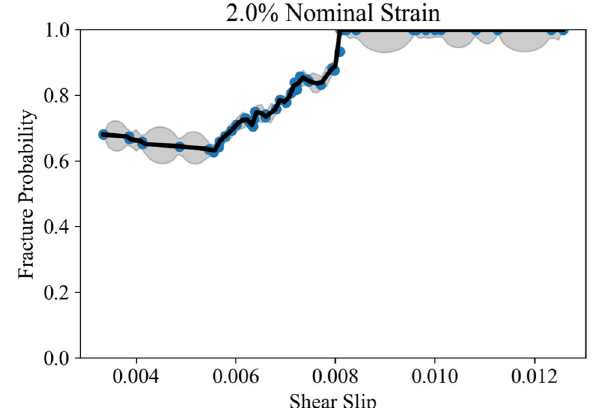
Fig. 11 Predicted probability of failure on test-set data at 1.25%, 1.5%, 1.75% and 2.0% strains. The ideal value is 1.0, or 100% probability.